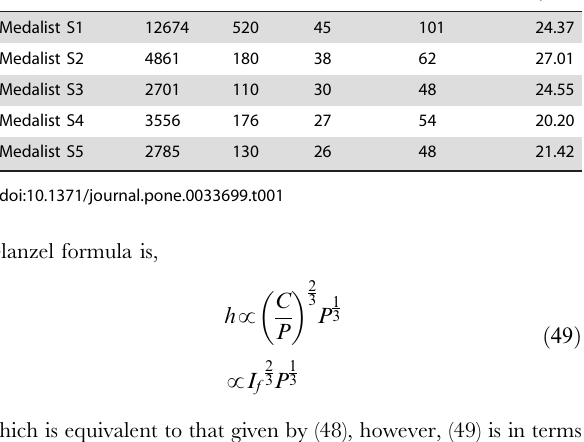
Table 2. Verification of theorems for the given set of Price Medalists.